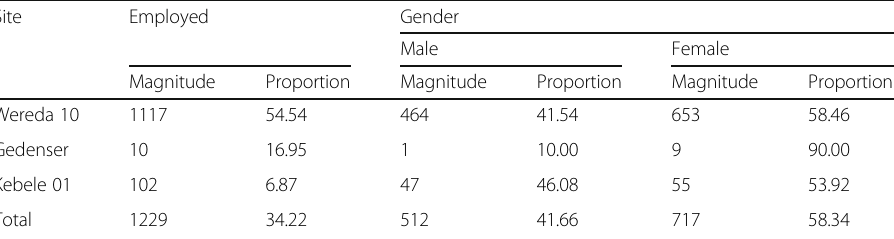
Table 5 Youth employment status and gender in overall project sites Site